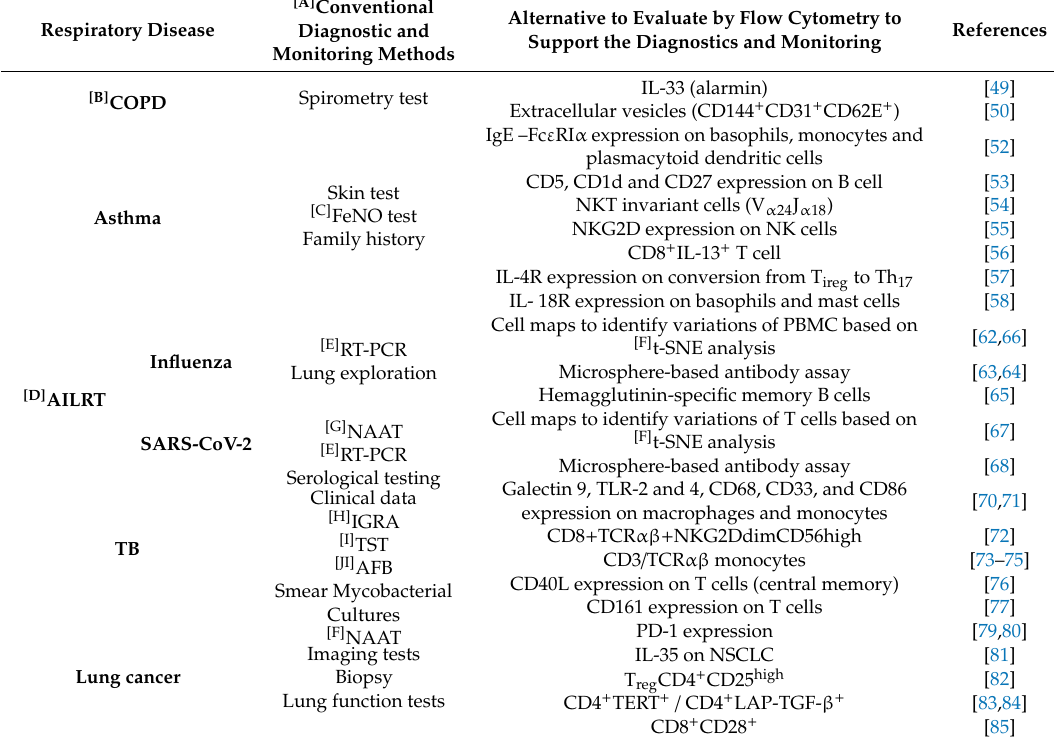
Table 1. Flow cytometry as an alternative in the diagnosis and monitoring of respiratory diseases. Respiratory